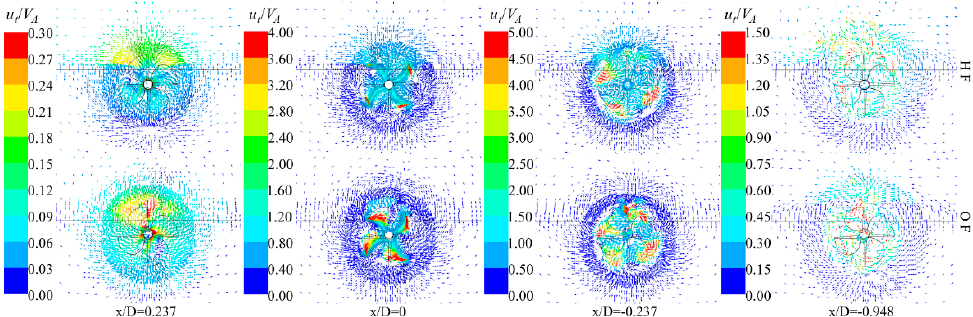
Water 2019 , 11 , x FOR PEER REVIEW Figure 20. Comparison of cross-flow vector at different cutting planes. Figure 20. Comparison of cross-flow vector at di ff erent cutting planes. Figure 20. Comparison of cross-flow vector at different cutting planes.